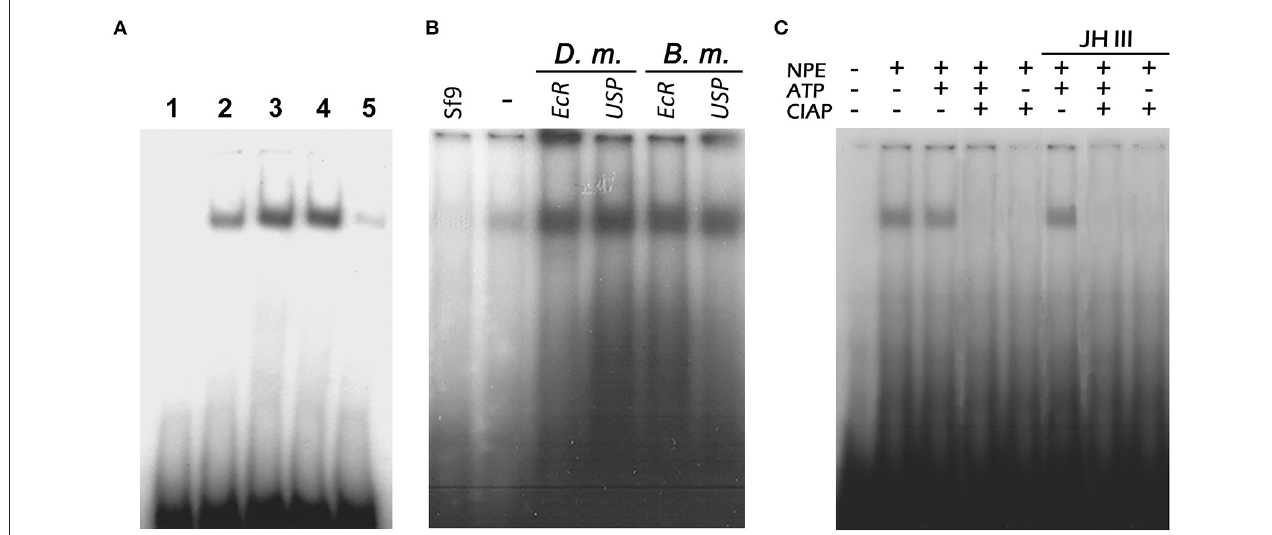
FIGURE 7 | Nuclear proteins binding specifically to P. americana Vg2 RE ( Vg2 RE). (A) Nuclear extracts of the fat body were incubated with 32 P-labeled 31-bp double-stranded oligonucleotides harboring the Vg2 RE. The DNA-protein complexes were separated on 5% polyacrylamide gels. Nuclear extracts from nymphs (lane 2) and males (lane 3) showed the same binding complex as previtellogenic female insects (lane 4), while no binding was observed in vitellogenic female insects (lane 5). Lane 1: No nuclear protein extract (NPE). (B) NPE from Sf 9 (lane Sf 9) and previtellogenic female fat body were incubated with radio-labeled 31-bp double-stranded oligonucleotides harboring the Vg 2RE in the absence (lane –) or presence of antibodies generated against D. melanogaster and B. mori EcR and USP before separating on 5% polyacrylamide gel. No super-shifted products were detected. (C) Dephosphorylation of the nuclear protein influence binding to the Vg2 RE. Female fat body nuclear extracts were incubated with either 1mM ATP, 2U of CIAP, or 1mM ATP followed by 2U CIAP at 22 ◦ C for 20min prior to the binding reaction with the 32 P-labeled probe containing the Vg2RE. ATP treated NPEs in the presence or absence of JH III showed a binding band when incubated with a Vg2 RE labeled